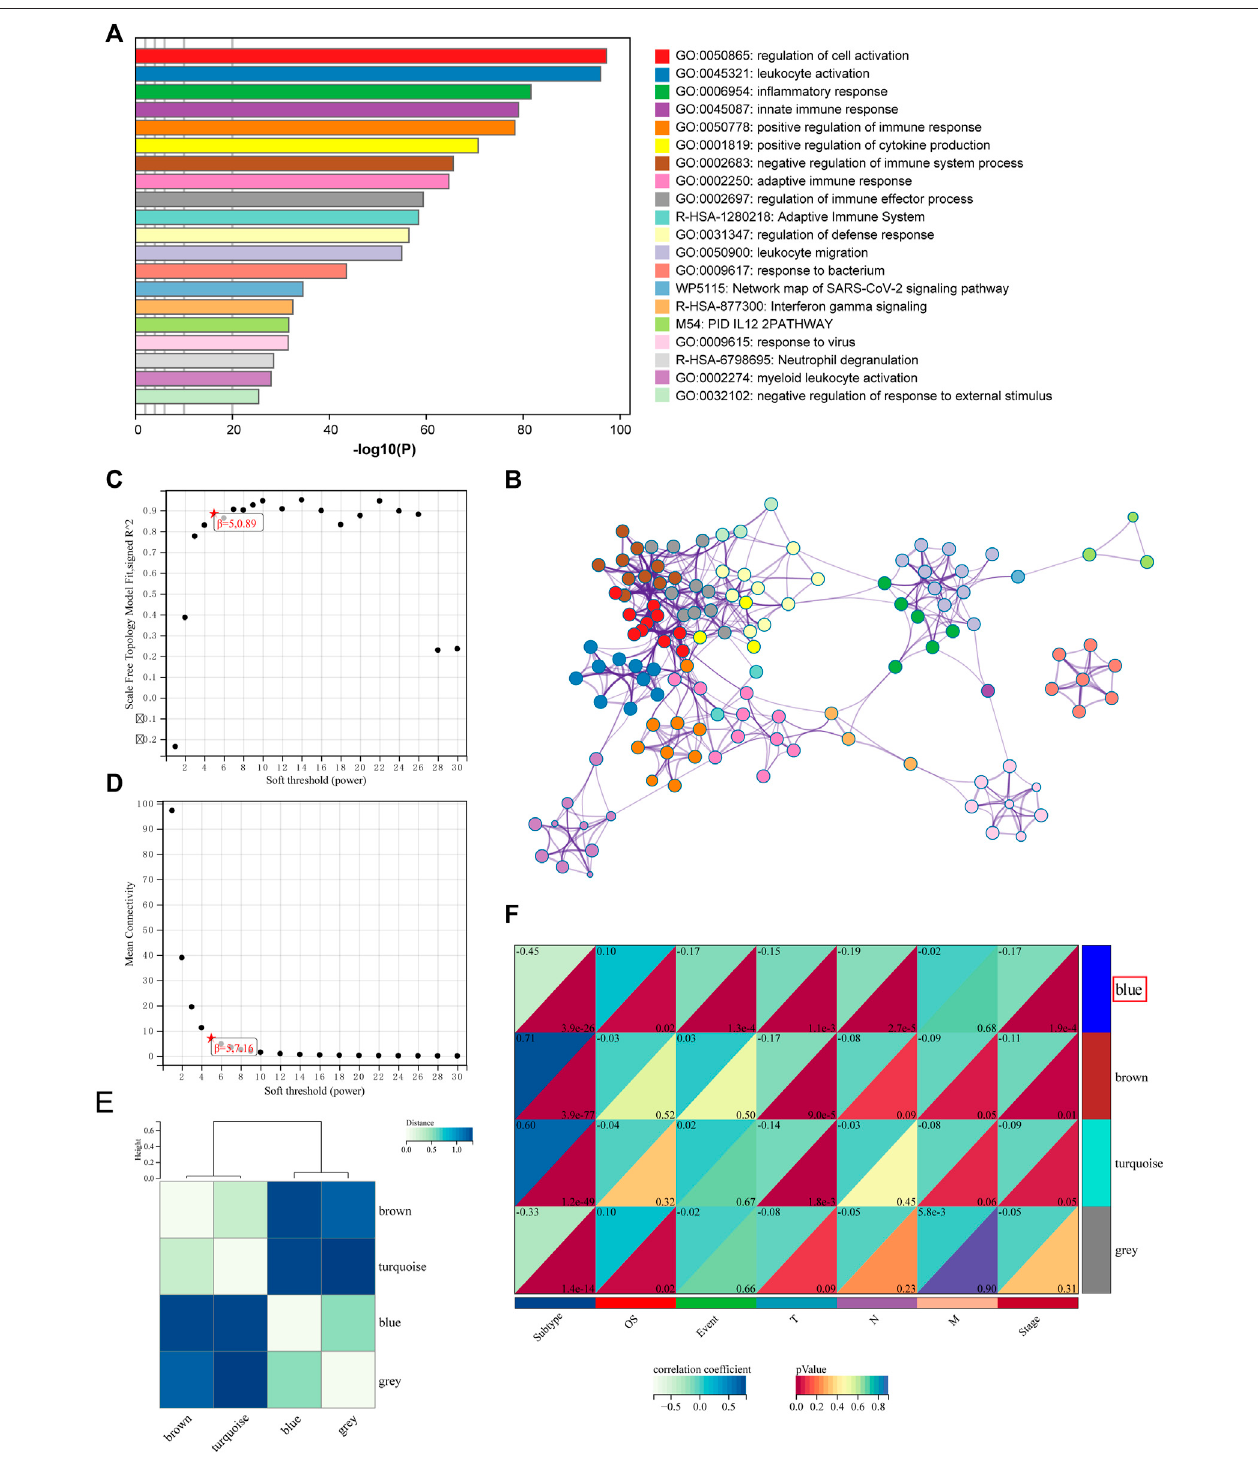
FIGURE 4 | Functional analysis and identi fi cation of the co-expression module. (A) Pathway and process enrichment analysis has been conducted for DEGs that are identi fi ed between the subtypes. The graphical representation showed top 20 enrichments with p < 0.01. (B) Enrichment terms with a similarity > 0.3 are connected by edges. (C – D) Analysis of the scale-free fi t index for various soft-thresholding powers and the mean connectivity for various soft-thresholding powers. (E) Clustering relationships among WGCNA modules. (F) Correlation between modules and clinical features. Blue represents a positive correlation, and white represents a negative